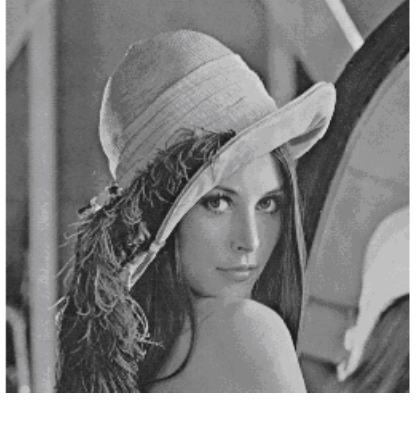
Figure 6. Resulting image by interchanging the SVs of the A image with those of the B